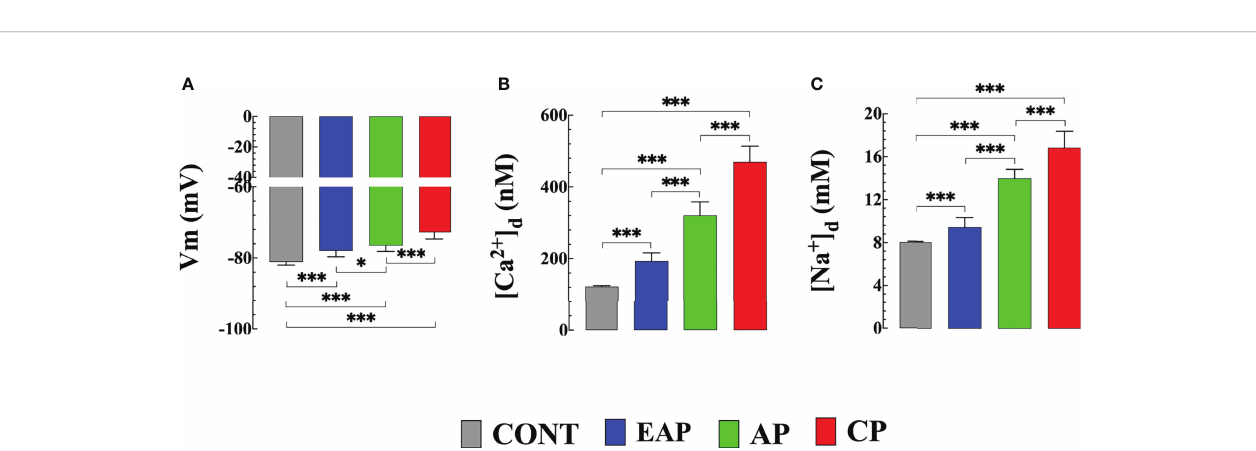
FIGURE 2 | Resting membrane potential, diastolic [Ca 2+ ] and [Na + ] in cardiomyocytes from control and Chagas infected mice. (A) The resting membrane potential, (B) [Ca 2+ ] d, and (C) [Na + ] d were measured in quiescent cardiomyocytes from CONT mice ( n cells =24 and n mice =3), EAP-infected mice ( n cells =19 and n mice =3), AP- infected mice ( n cells =21 and n mice =3) and CP-infected mice ( n cells =18 and n mice =5). Data are expressed as means ± S.D. Statistical analysis was performed using one-way ANOVA, followed by Tukey ’ s multiple comparison tests, * p < 0.05; *** p < 0.001. CONT, control mice; EAP, early acute phase of infected mice; AP, acute phase of infected mice; and CP, chronic phase of infected mice.